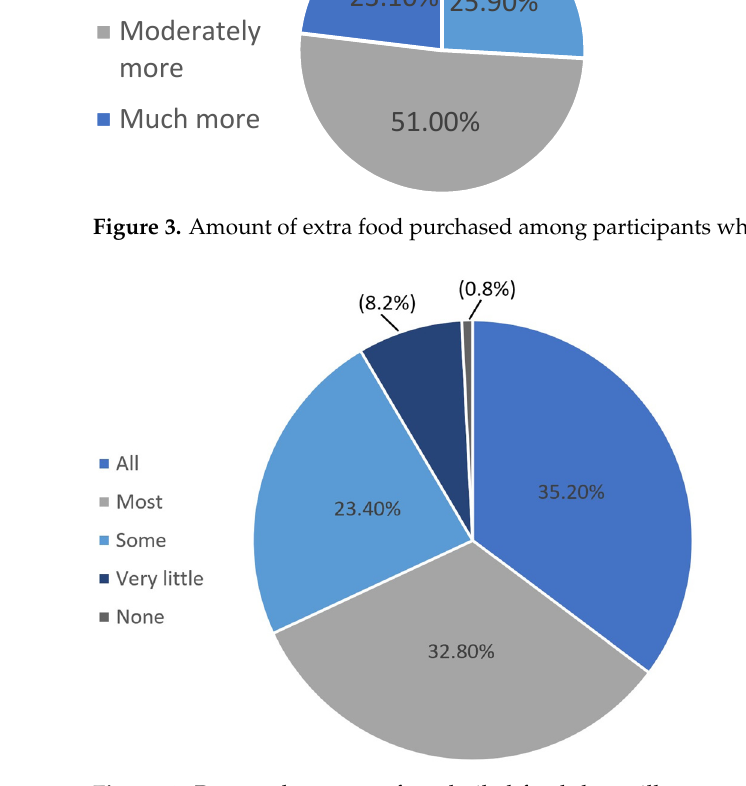
Figure 4. Reported amount of stockpiled food that will eventually be consumed by someone in the household. the